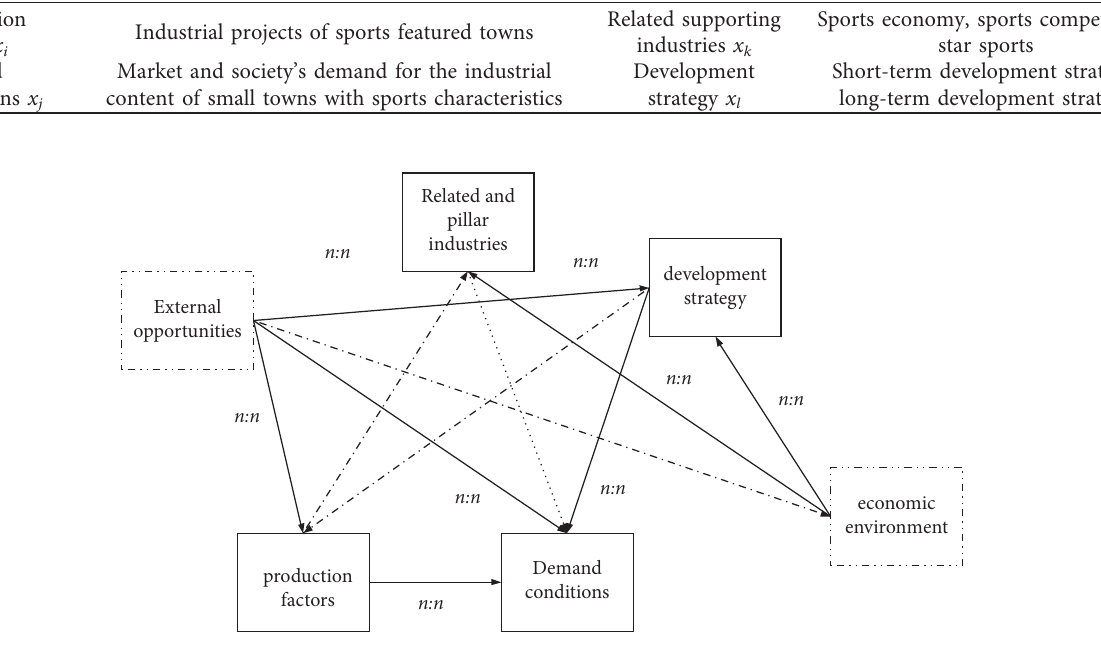
Figure 1: Relationship between influencing factors in the “Diamond Model”